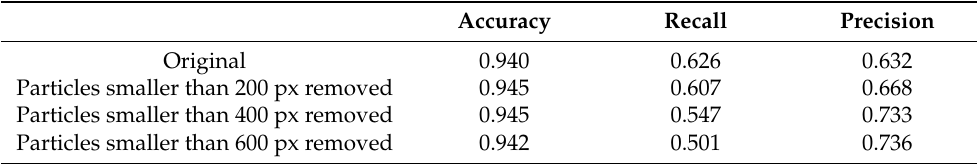
Table 13. Accuracy, recall, and precision (small number of